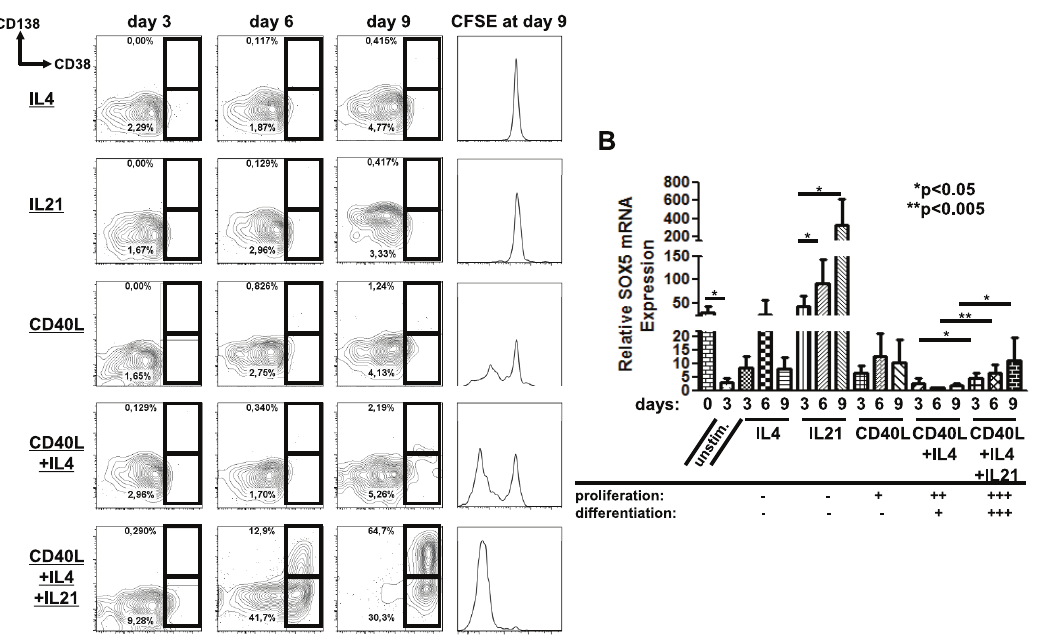
Figure 4. Induction of SOX5 during invitro B cell differentiation. (A) Isolated peripheral blood B cells were either left for 3 days without any stimulus or stimulated for 9 days in vitro either with a single stimulus (IL4, IL21 and CD40L) or the combination of these (CD40L + IL4 + / 2 IL21). The cells were analyzed by FACS for the plasma cell markers CD138 and CD38 at days 3, 6 and 9. Gates indicate the frequency of CD138 + CD38 hi plasmablasts in each plot. CFSE at day 9 was measured as an indicator of proliferation in the cells. Representative FACS plots of five independent experiments are shown. (B) RT-qPCR analysis of SOX5 expression in ex vivo B cells and samples either unstimulated (unstim.) for 3 days or stimulated with a single stimulus (IL4, IL21 and CD40L) or the combination of these (CD40L + IL4 + / 2 IL21). Significant differences are depicted and appropriate t- test p-values (n=5; p , 0.05) are indicated. Relative expression levels of SOX5 are shown as mean 6 SD. RPLP0 gene served as an internal control in the